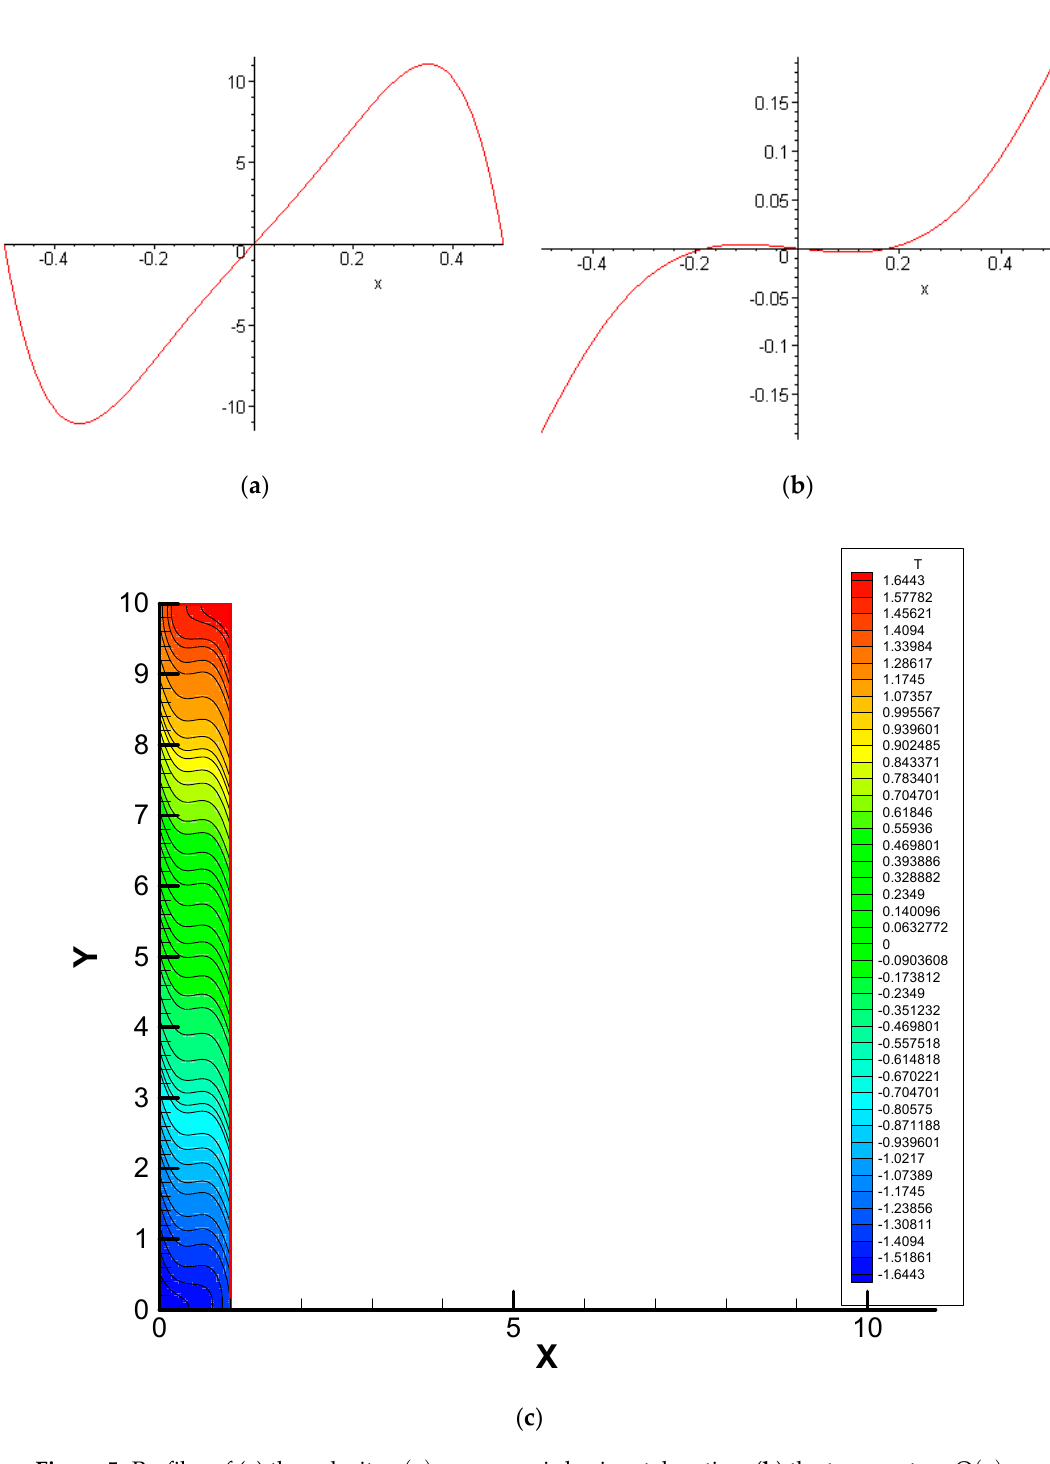
Figure 5. Profiles of ( a ) the velocity v ( x ) on a generic horizontal section; ( b ) the temperature Θ ( x ) on the horizontal section at y = 0; and ( c ) the temperature